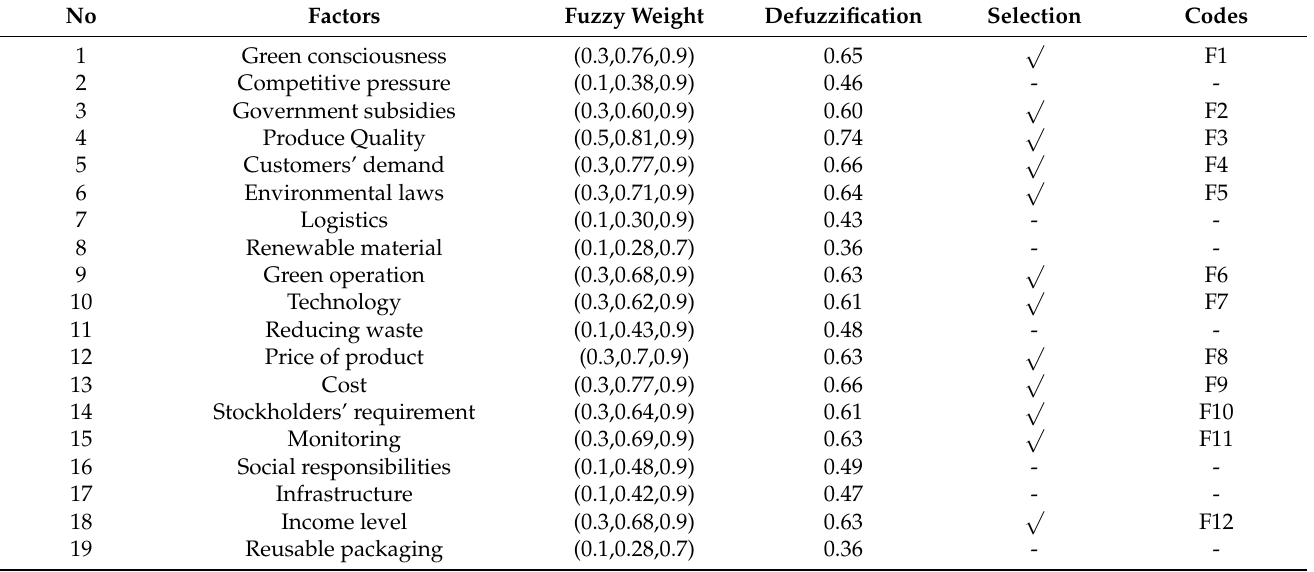
Table 6. Finalizing factors using fuzzy Delphi.